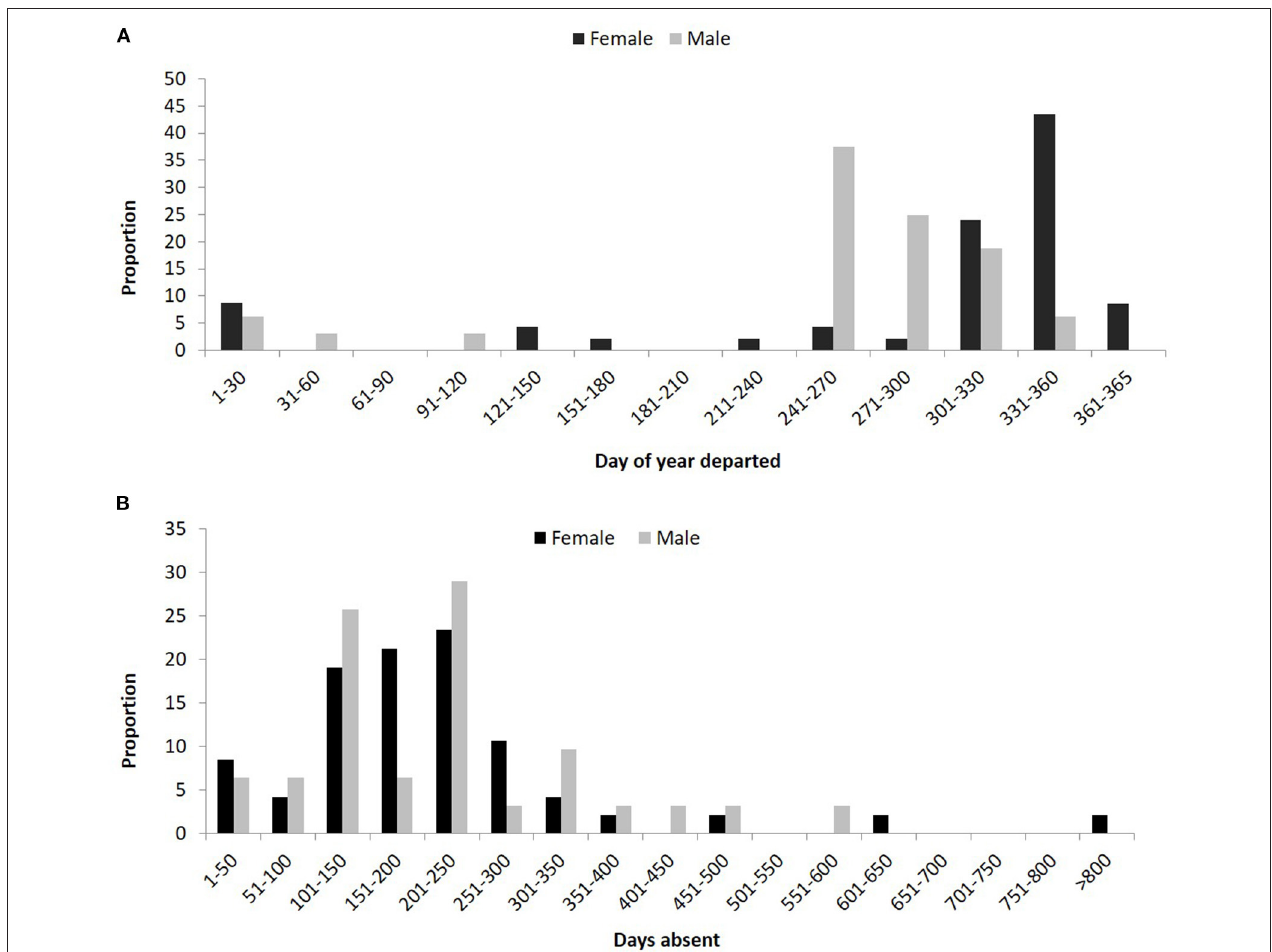
FIGURE 9 | (A) Proportion of resident adult male and female lemon sharks that departed the Mangrove Bay array on day of year with 1 being January 1 and 365 December 31. (B) Proportion of resident adult male and female lemon sharks that were absent from the Mangrove Bay array for a certain number of days.